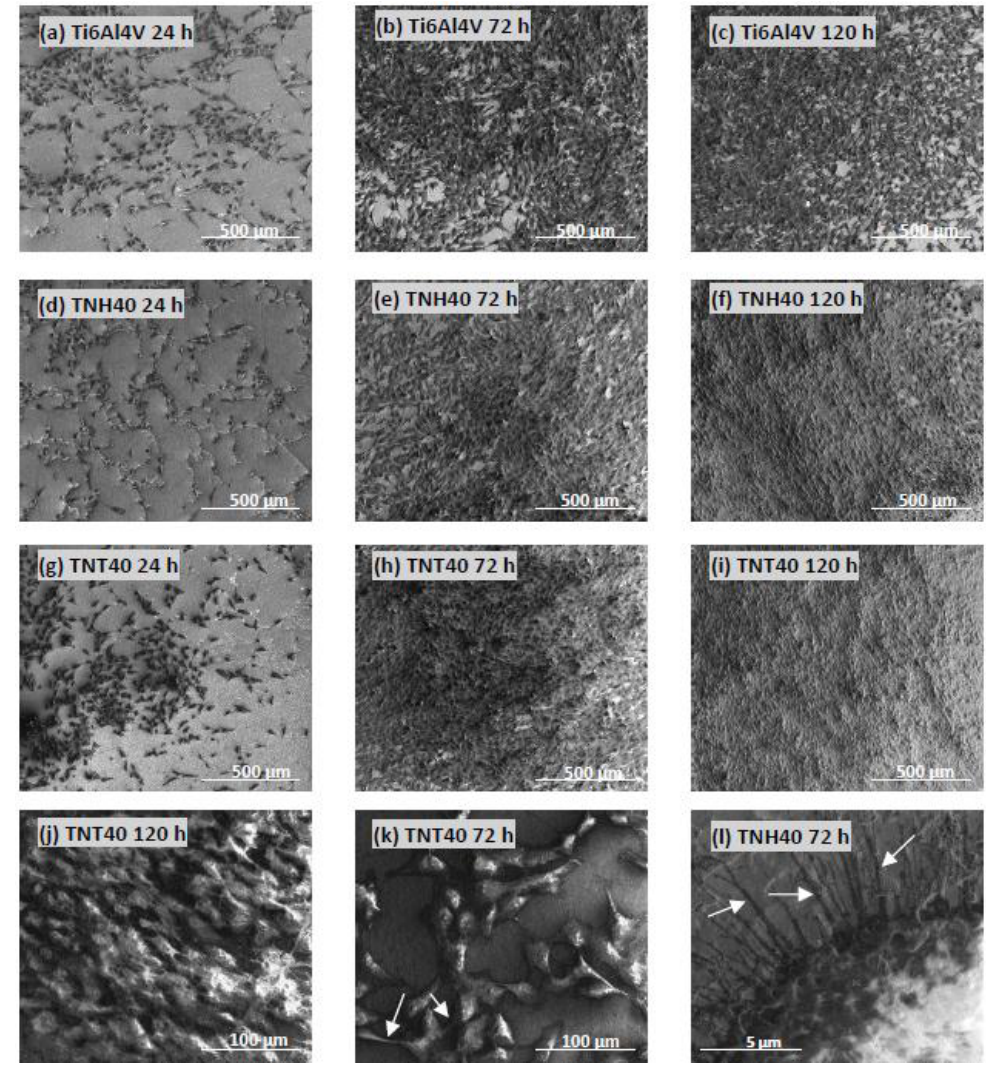
Figure 9. Scanning electron microscopy (SEM) micrographs showing the human osteoblast-like MG-63 cell proliferation on the surface of the references sample (Ti6Al4V; ( a – c ) compared to Ti6Al4V/TNH40 sample; ( d – f ) and the Ti6Al4V/TNT40 sample; ( g – i ). Micrograph ( j ) presents the multilayer growth of cells. Arrows indicate numerous filopodia spreading between cells ( k ) or filopodia, which attached osteoblasts to the nanocoatings surface ( l ).